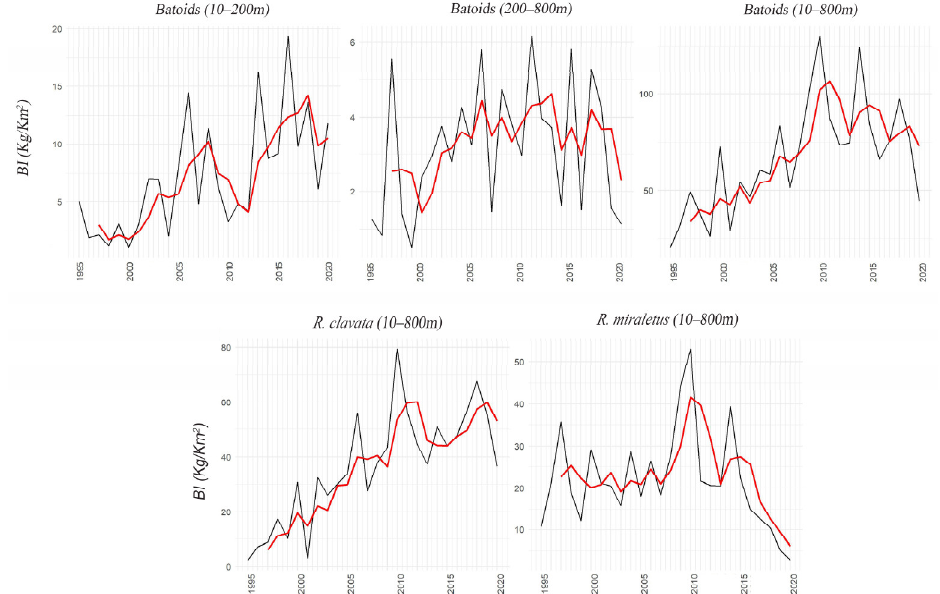
Figure 3. Trend of observed (black lines) MEDITS survey biomass index (kg/km 2 ) over the years and 3-year rolling mean (red lines) for batoids in the Strait of Sicily.